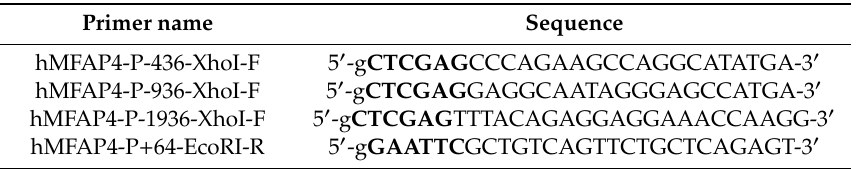
Table 1. The primers used in the study.